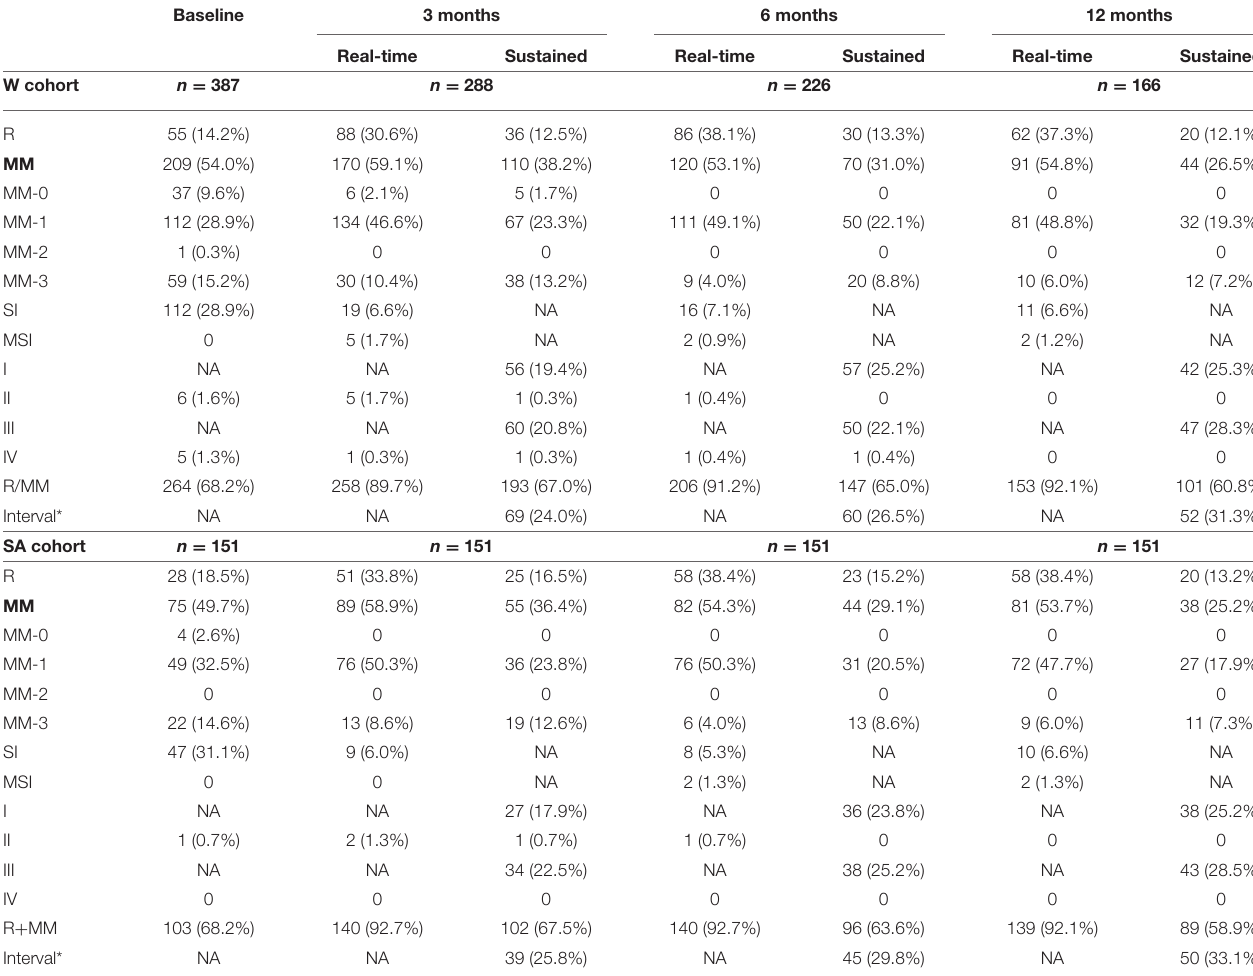
TABLE 1 | Patients belonging to each PIS category at baseline and each follow-up in the whole cohort and the sensitivity analysis cohort (number, %). Baseline 3 months 6 months 12